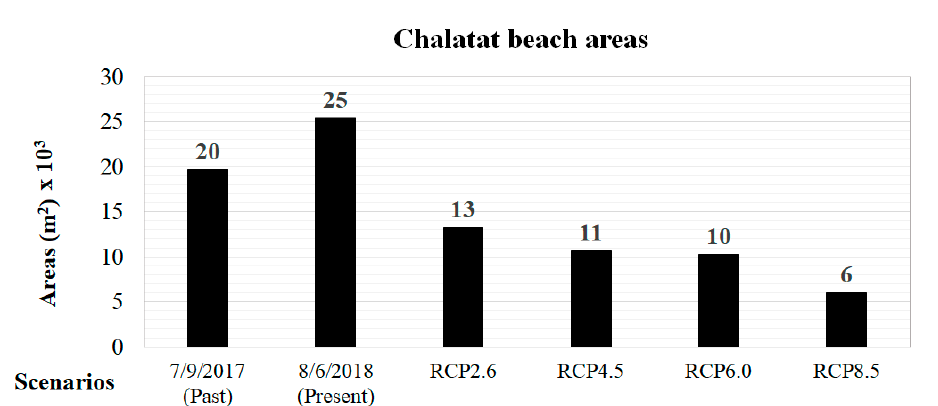
Figure 6. Pattaya beach area.